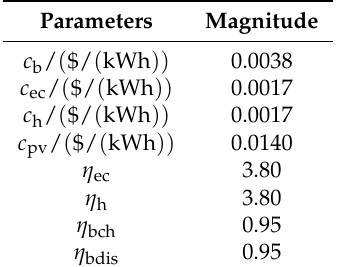
Table 3. Parameters of microgrid